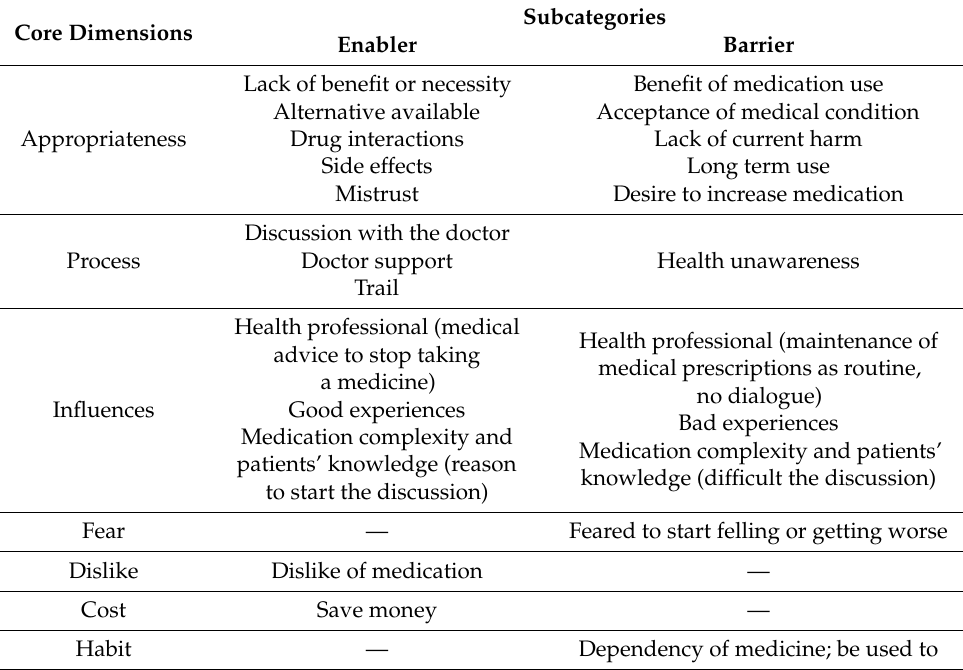
Table 1. Focus Group analyses: factors to consider in